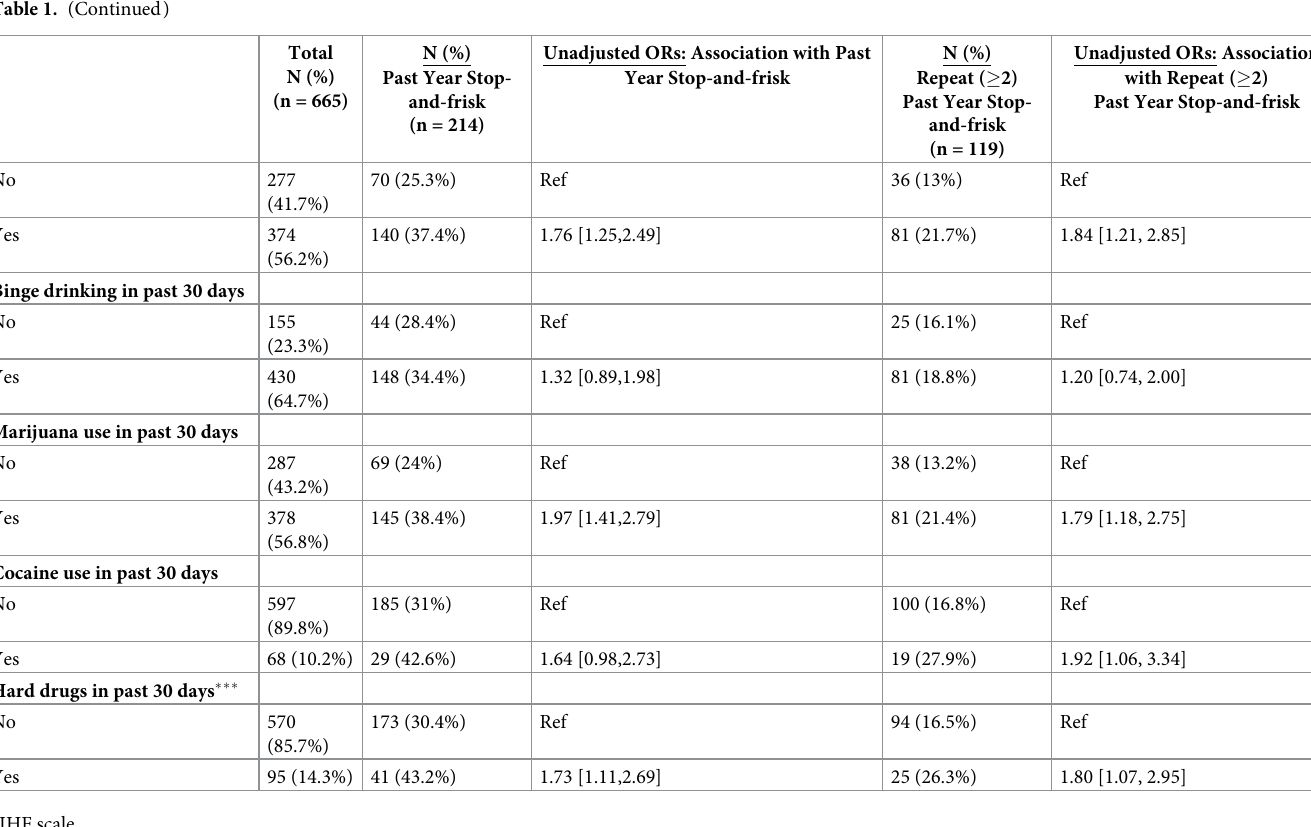
final follow-up a significant minority of P18 participants continued to report past year stop- and-frisk, including one in nine White and non-Black participants and one in seven Black par- ticipants. The vast differences in the levels of self-reported stop-and-frisk experience in the P18 compared with per capita rates based on the NYPD records are consistent with docu- mented underreporting in NYPD records [14], but also suggest that sexual minority men across race/ethnicity may experience much higher rates of police contact than non-sexual minority populations. We observed Black YSMM who lie at the intersection of racial minority and sexual minority status face the greatest vulnerability and that YSMM with the greatest eco- nomic and social vulnerability were most likely to report stop-and-frisk experience. Those with very high numbers of stop-and-frisk events demonstrated substantial psychosocial vul- nerability highlighting how syndemics of stigma, internalized homophobia, and adverse men- tal health, in conjunction with criminal legal system contact, negatively affect some Black YSMM. This increased exposure was loosely associated with Black participants’ residing in neighborhoods with histories of being heavily policed. Stop-and-frisk adds to the burden of structural and systematic discrimination that is known to degrade health, well-being and sense of safety in this already vulnerable group [26, 27]. Together, results indicating the pervasive experience of stop-and-frisk among YSMM, particularly Black YSMM, highlight the need for reduction of this stressful and deleterious life event among YSMM. The results underscore